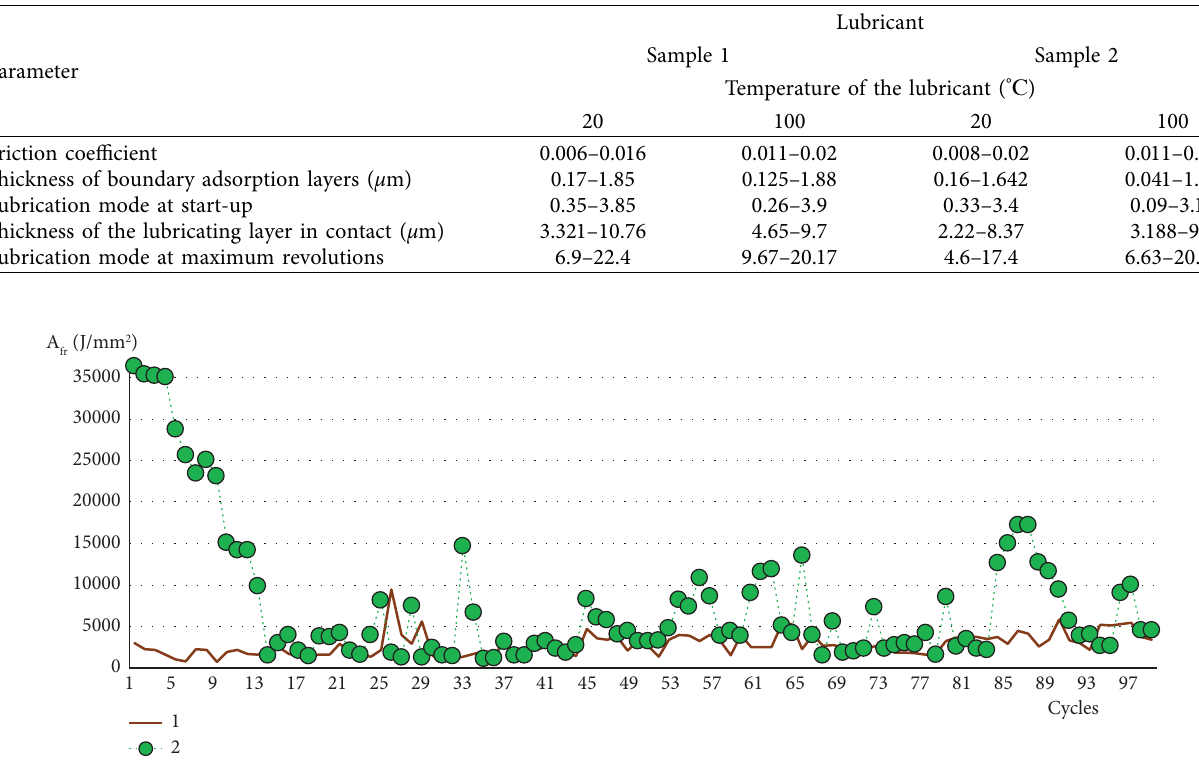
Figure 7: Kinetics of changes in the specifc work of friction ( A